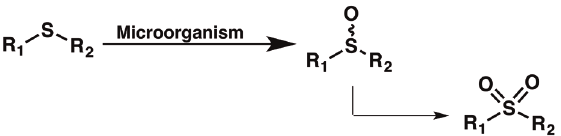
Figure 3 - Oxidation of a sulfide to sulfoxides and